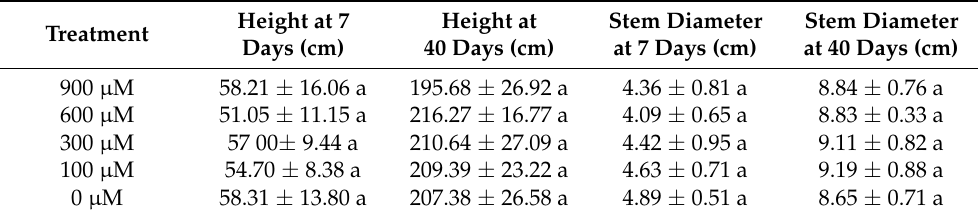
Table 1. Height of stem diameters of R. communis plants before treatment with salicylic acid at days 7 and 40 after